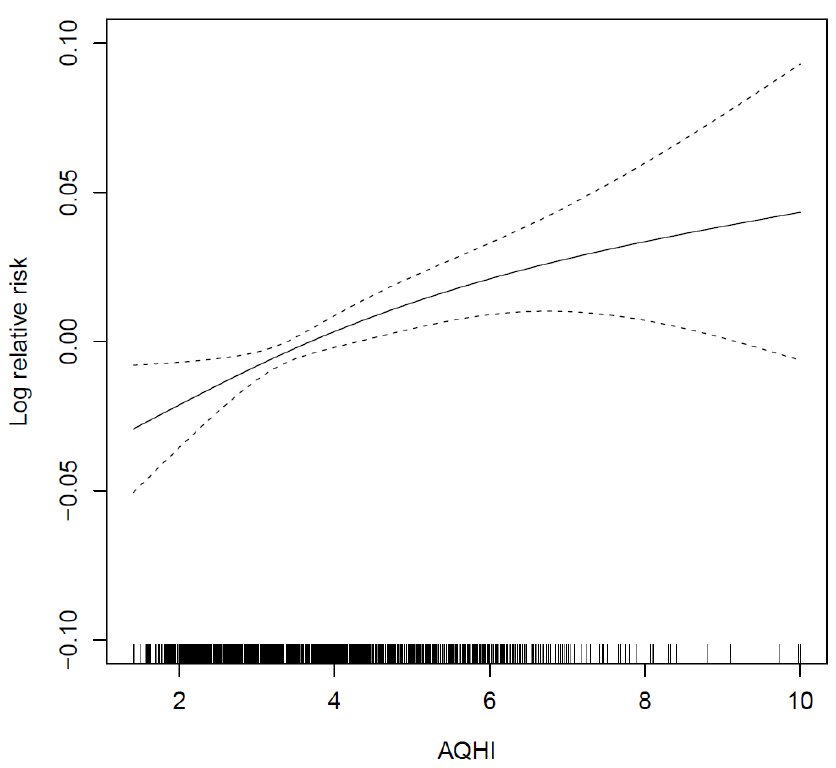
Figure 6. Exposure–response relationship curve for the association between the AQHI and total mortality rate of citizens.